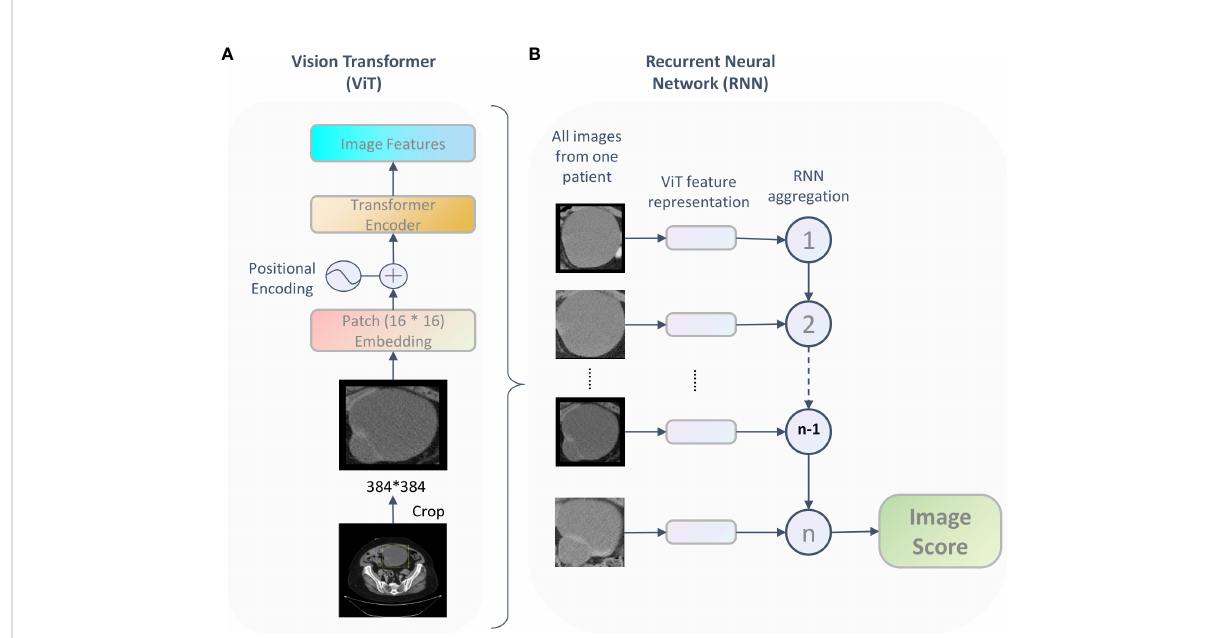
FIGURE 1 The framework of the proposed Vit-based model. For each patient, being fed tumor images, the deep learning model output an image score which represent the patient ’ s survival probability. This framework includes two parts: the ViT part (A) learned features and the RNN part (B) integrated the feature representation for each patient and reported the fi nal image